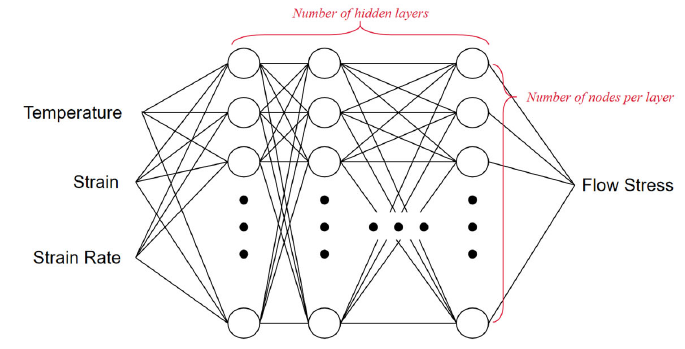
Figure 2. Illustration of the ANN for predicting the flow stress.